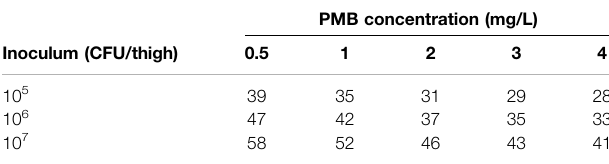
TABLE 3 | Model derived initial killing half-lives (min) at various unbound PMB concentrations and starting